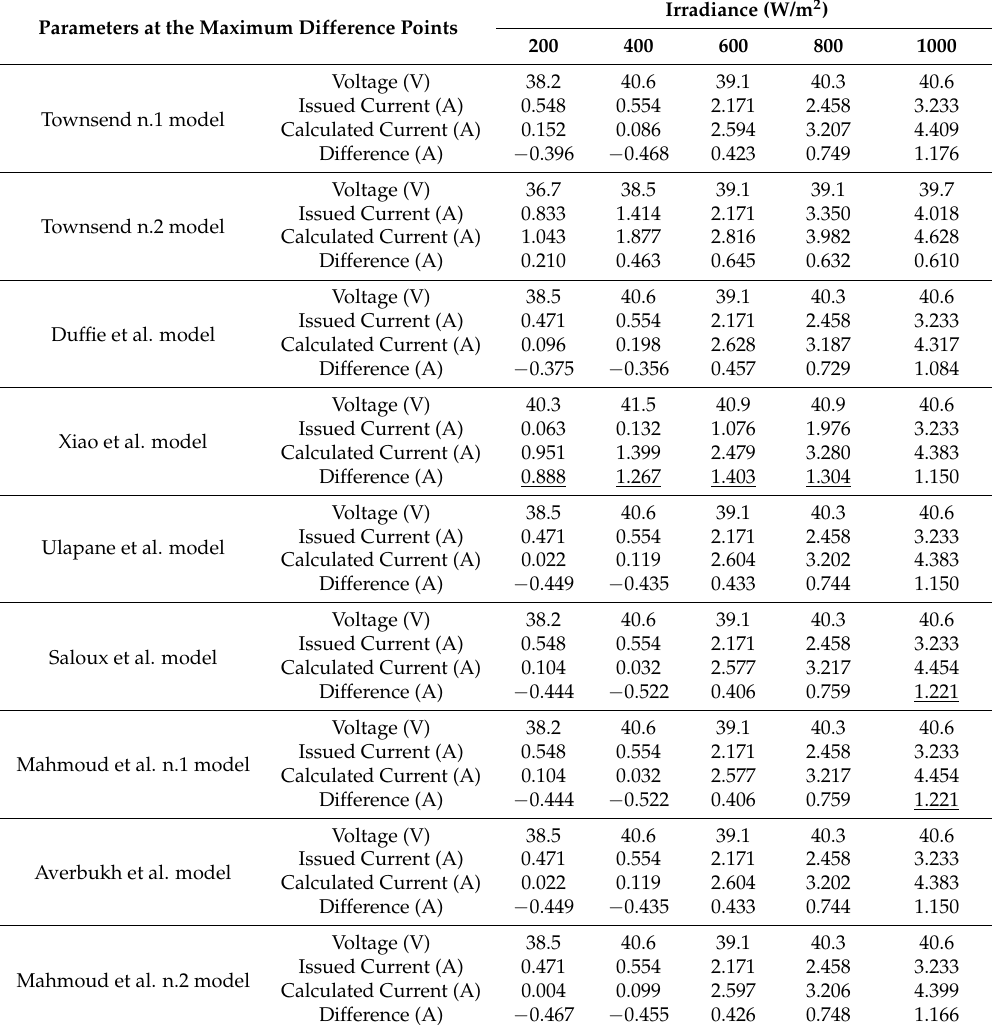
Table 8. Maximum current differences between the calculated and the issued I-V characteristics of Sanyo HIT-240 HDE4, at temperature T = 25 ◦